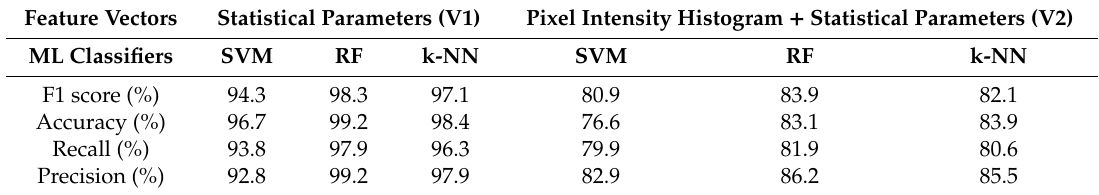
Table 3. Overall results of implemented feature vectors and the di ff erent ML